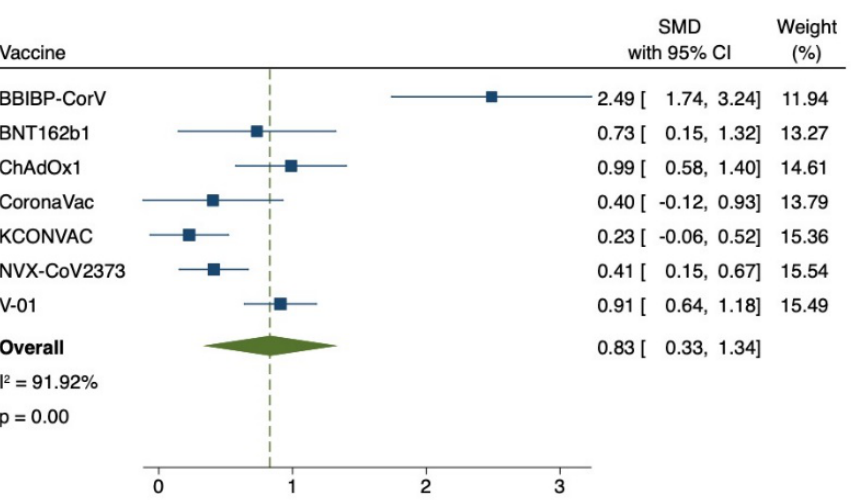
Figure 4. Meta-analysis of GMTS after the last vaccination versus the first vaccination in older adults. Blue squares represent effect sizes for a single study, and green rhombus represent pooled results for all studies.